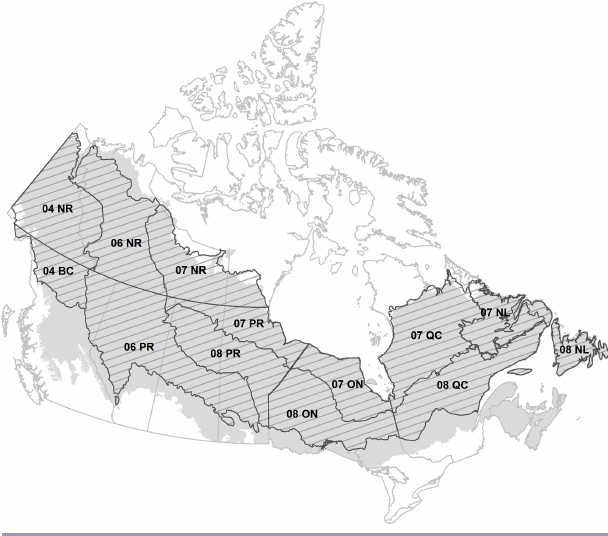
Fig. 2 . Study region map. Bird conservation subregions outlined in dark gray and cross-hatched. NR = Northern Region; PR = Prairie Region. BC = British Columbia; ON = Ontario; QC = Québec; NL = Newfoundland and Labrador. Brandt’s (2009) boreal region shaded light